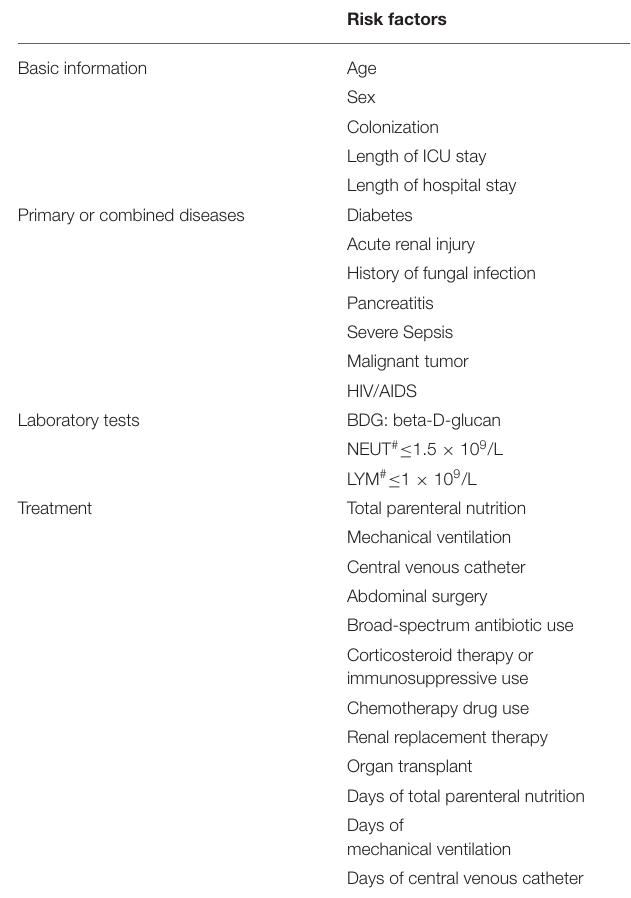
TABLE 1 | Risk factors for previous